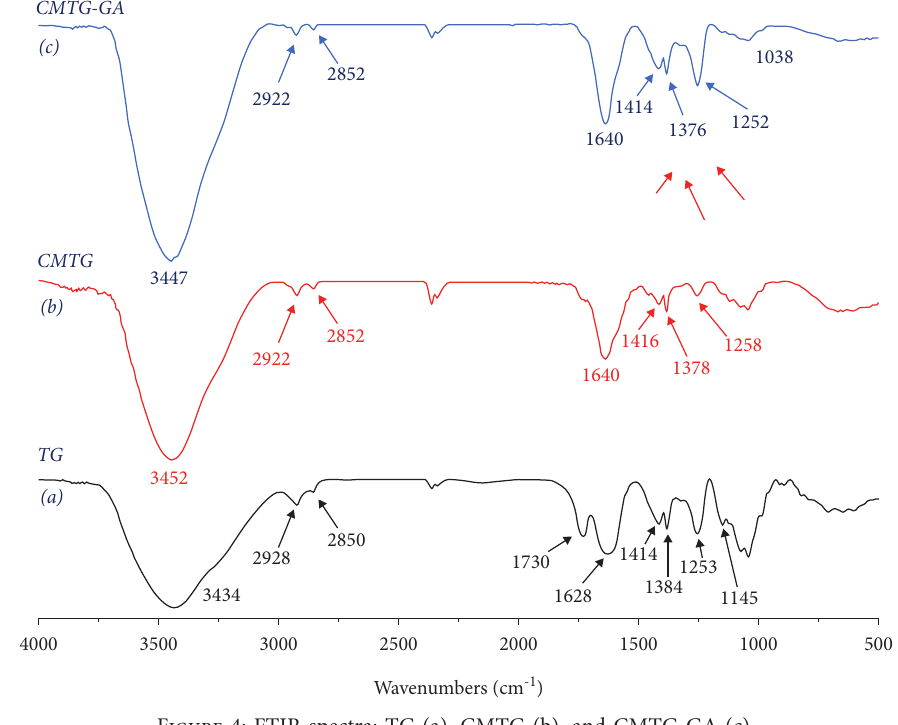
Figure 4: FTIR spectra: TG (a), CMTG (b), and CMTG-GA (c).